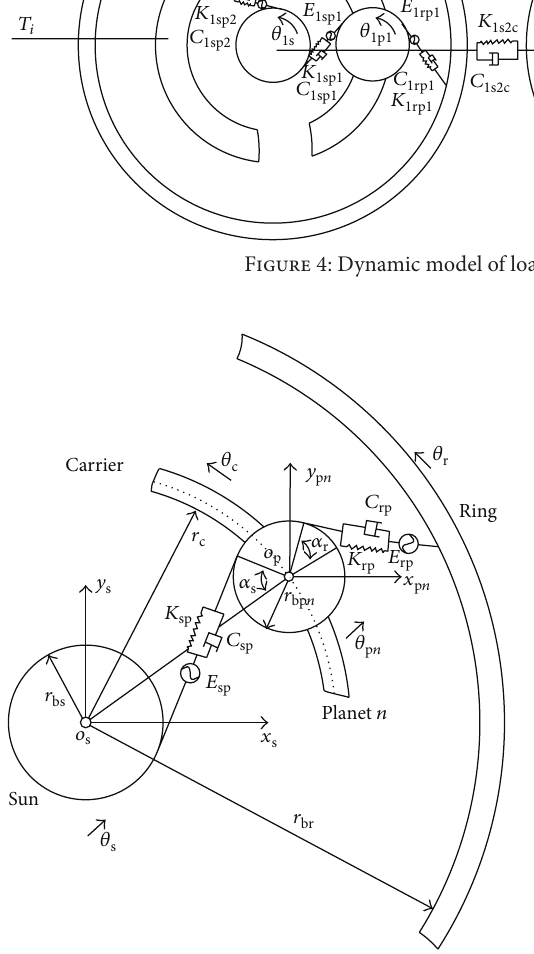
Figure 5: Torsional model of single-stage planetary